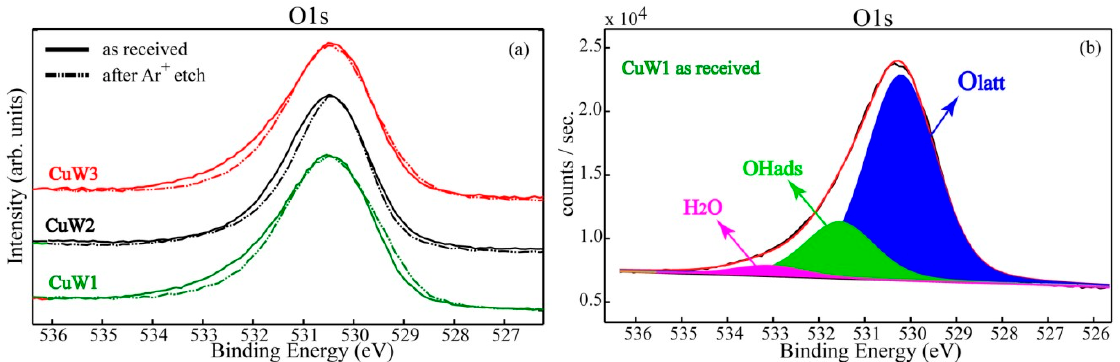
Figure 8. The superimposed O1s of CuW1, CuW2, and CuW3 in the “as received” stage and after a gentle Ar ion etching ( a ) and the singlet O1s deconvoluted spectrum for the CuW1 sample in the “as received” stage ( b ).